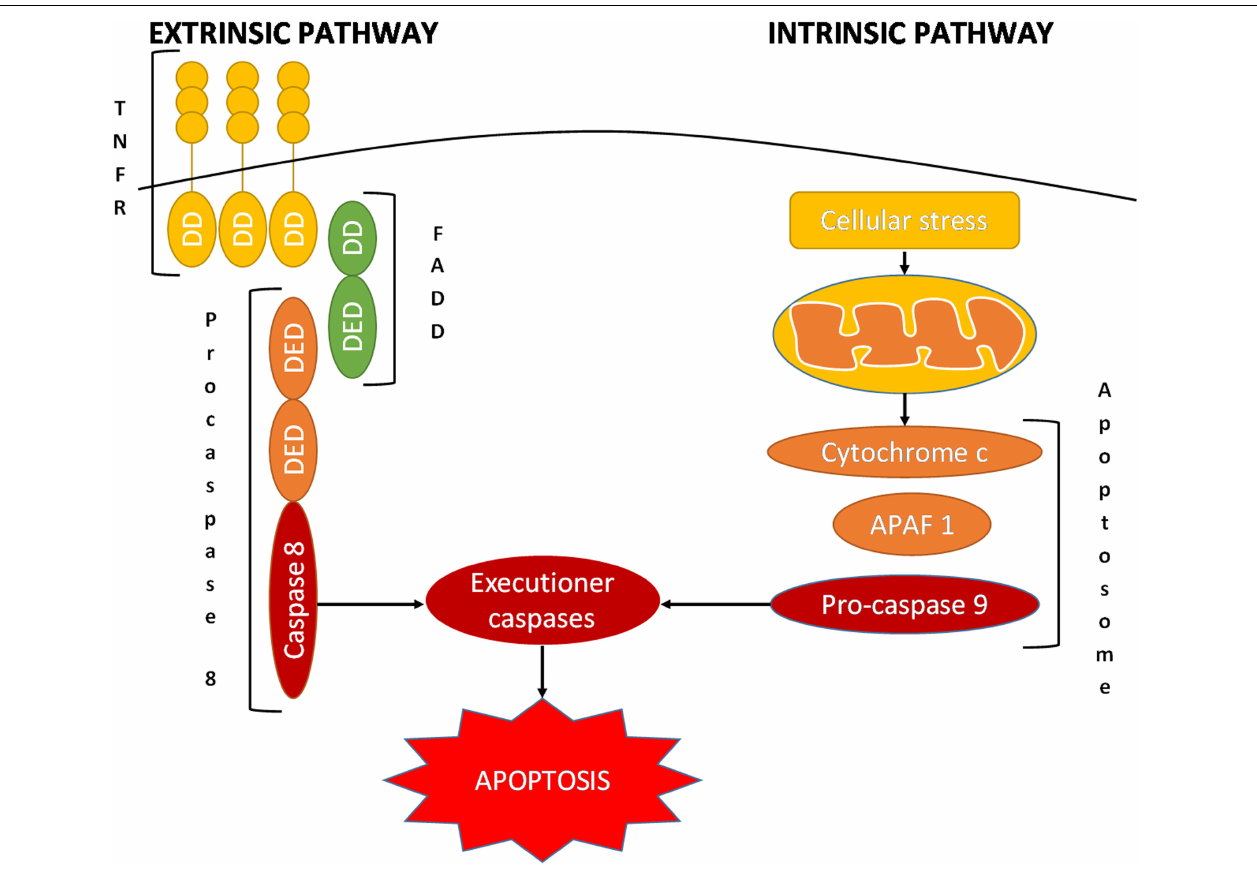
FIGURE 2 | Schematic representation of the extrinsic and intrinsic pathways of apoptosis. APAF 1, apoptotic protease-activating factor 1; DD, death domain; DED, death effector domain; FADD, Fas-associated protein with death domain; TNFRSF, tumor necrosis factor receptor